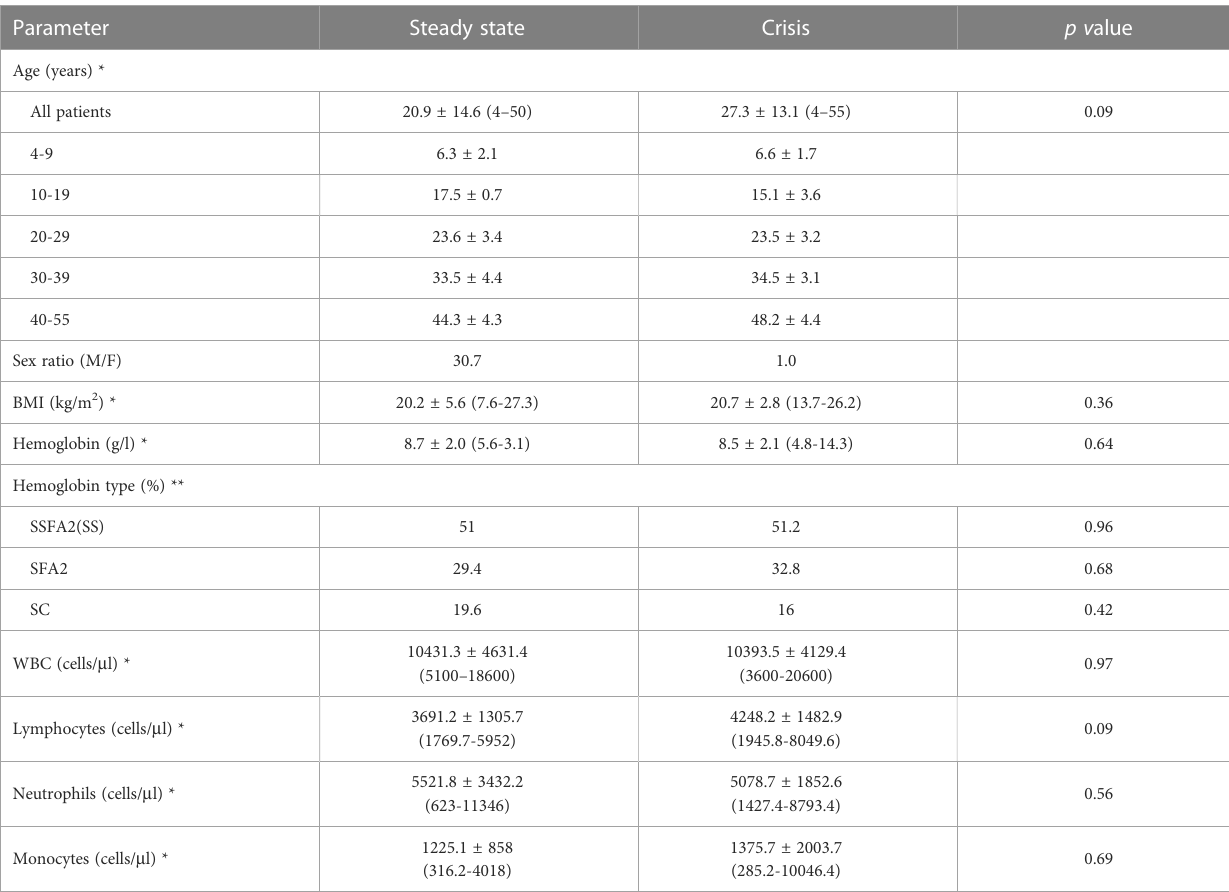
TABLE 1 Demographic and hematological characteristics of sickle cell patients. Parameter Steady state p v